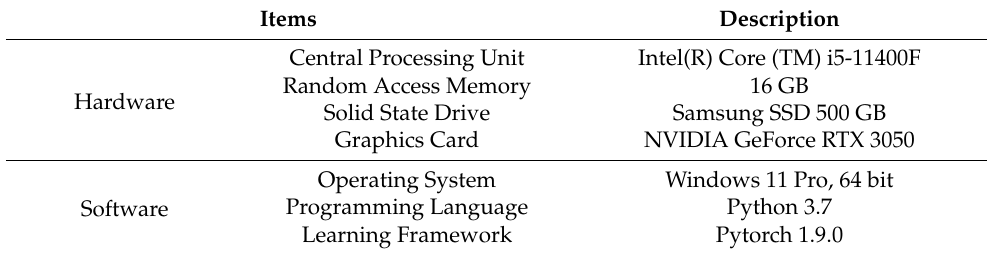
Table 3. Workstation mainframe hardware and software.